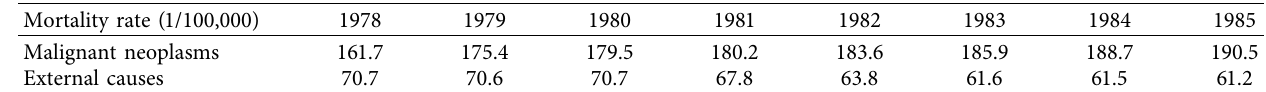
Table 5: The mortality rate of malignant neoplasms and external causes in the US. Mortality rate (1/100,000) 1978 1979 Malignant neoplasms External causes